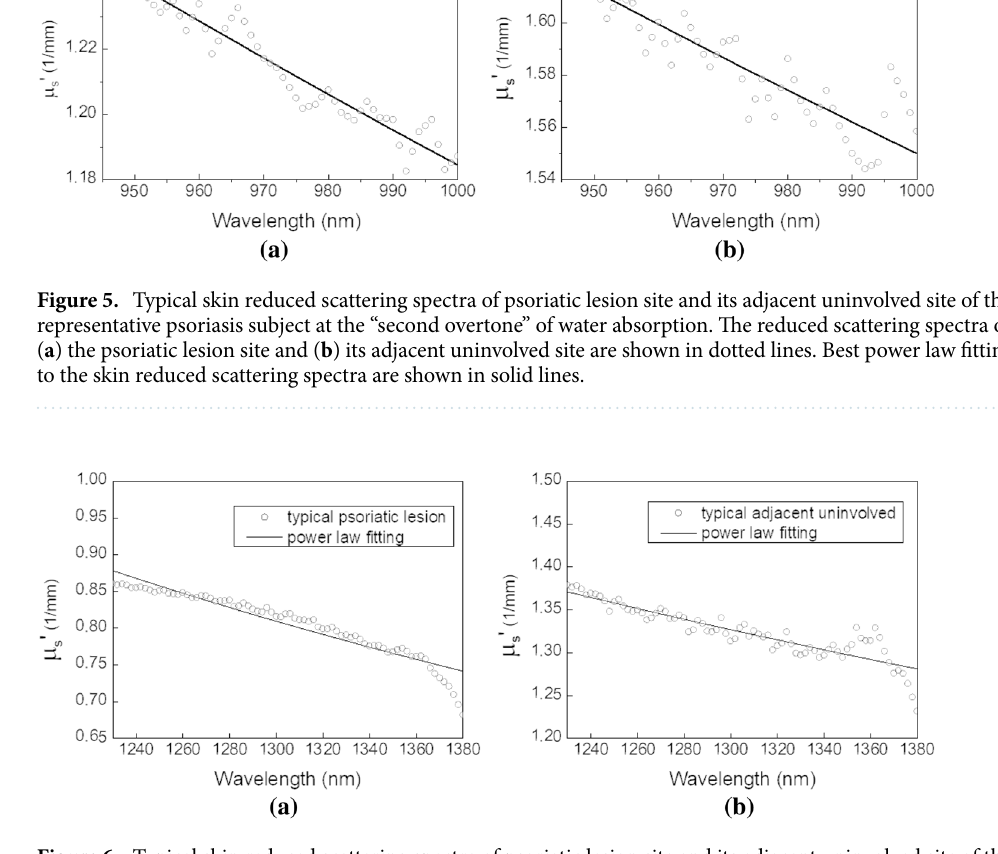
Statistical analyses of skin reduced scattering spectra. One-way ANOVA was performed to investigate the reduced scattering coefficients differences between various skin sites of the 21 psoriasis subjects and 21 normal subjects. We only selected the reduced scattering coefficients at 970 nm and 1300 nm for the analyses. The analy- sis results are summarized in the box-and-whisker plots illustrated in Fig. 7. One-way ANOVA indicated that the 970 nm reduced scattering coefficients of the four measurement sites were significantly different ( P = 6.61E−7). Employing further Scheff ѐ tests revealed that the psoriatic lesions had significantly lower 970 nm reduced scat- tering coefficients than those of adjacent uninvolved skin, uninvolved upper inner arm skin, and normal upper inner arm skin. The complete Scheff ѐ test results are listed in the inset of Fig. 7a. On the other hand, at 1300 nm wavelength, the reduced scattering coefficients of the uninvolved arm group had highest mean as shown in Fig. 7b. This data distribution is qualitatively similar to that of 970 nm reduced scattering coefficients shown in Fig. 7a. One-way ANOVA indicated that the 1300 nm reduced scattering coefficients of the four measurement sites were significantly different ( P = 3.76E−5). Scheff ѐ test results indicate that at 1300 nm the reduced scattering coefficients of psoriatic lesions were not significantly lower than those of normal skin ( P = 0.19), which is dif- ferent from the results shown in Fig. 7a. At 1300 nm wavelength, the reduced scattering coefficients of psoriatic lesion were significantly lower than those of adjacent uninvolved skin and uninvolved upper inner arm skin ( P = 0.01 and P = 7.38E−5). Our results suggest that while the light scattering property of skin at either the first or the second overtone of water absorption band could be used for psoriasis diagnosis, using second overtone band would be more effective than the first overtone band. This is reasonable since the skin reduced scattering coef- ficient decreases as wavelength increases, and the difference between the light scattering property of psoriatic lesion and normal skin would be more prominent at the shorter wavelengths. We further analyzed the values of the magnitude “a” and the exponent “b” of the scattering power law that fit to the skin reduced scattering spectra. Surprisingly, we found one-way ANOVA results that neither “a” nor “b” values derived from 940 to 1000 nm or 1230 to 1380 nm showed significant differences between the measurement sites. We observed that the span of “a” and “b” values of the 21 psoriatic lesion sites were quite large as compared